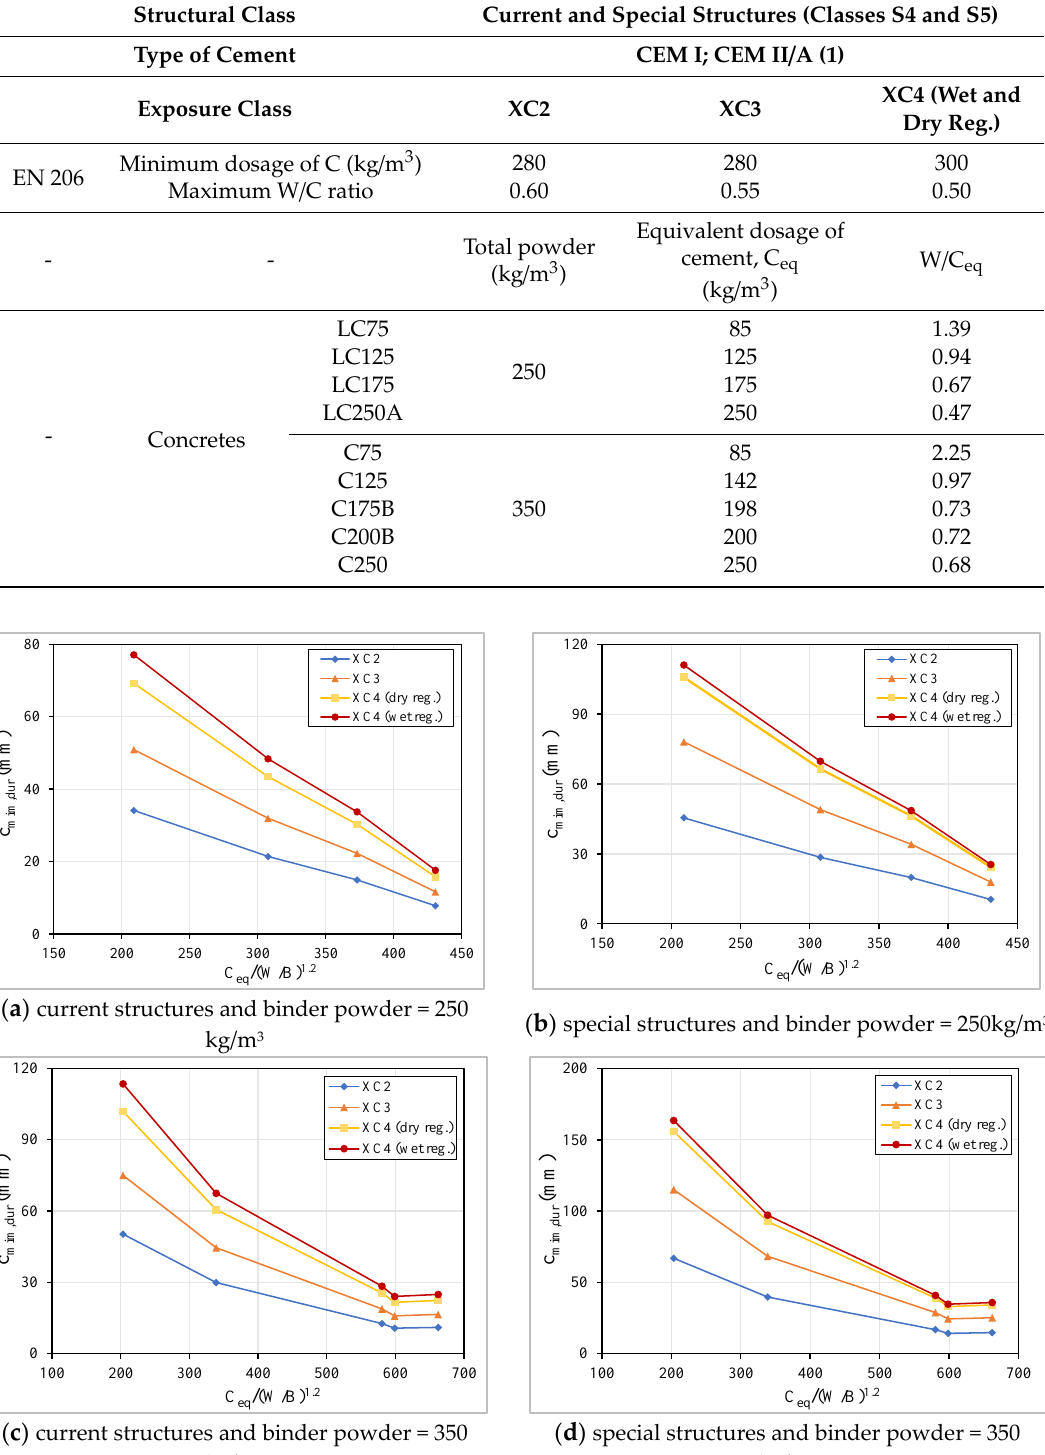
( d ) special structures and binder powder = 350 Figure 24. Relation between the c min,dur vs. the relation C eq /(W/B) 1.2 . Figure 24. Relation between the c min,dur vs. the relation C eq / (W / B) 1.2 Table 7. Minimum dosage of cement according to standards and equivalent dosages used in the concretes studied.